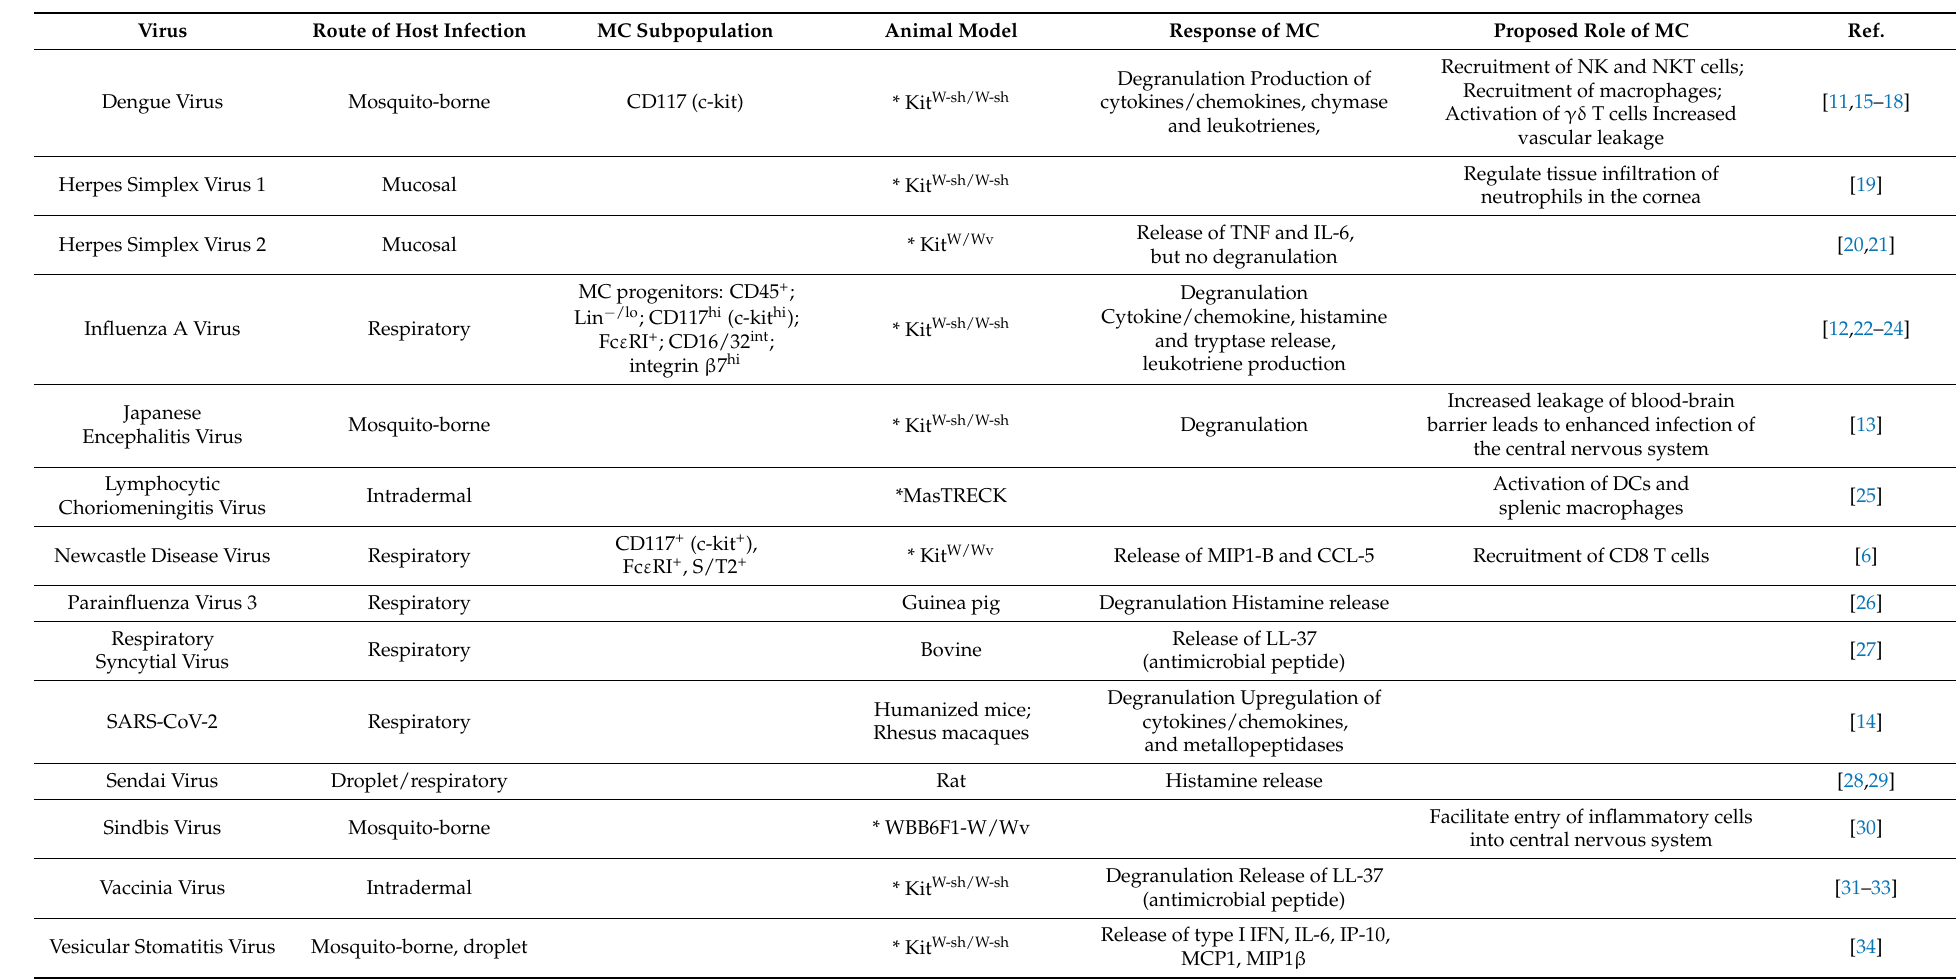
Table 1. Involvement of MC in control or exacerbation of viral infections. * MC-deficient mouse